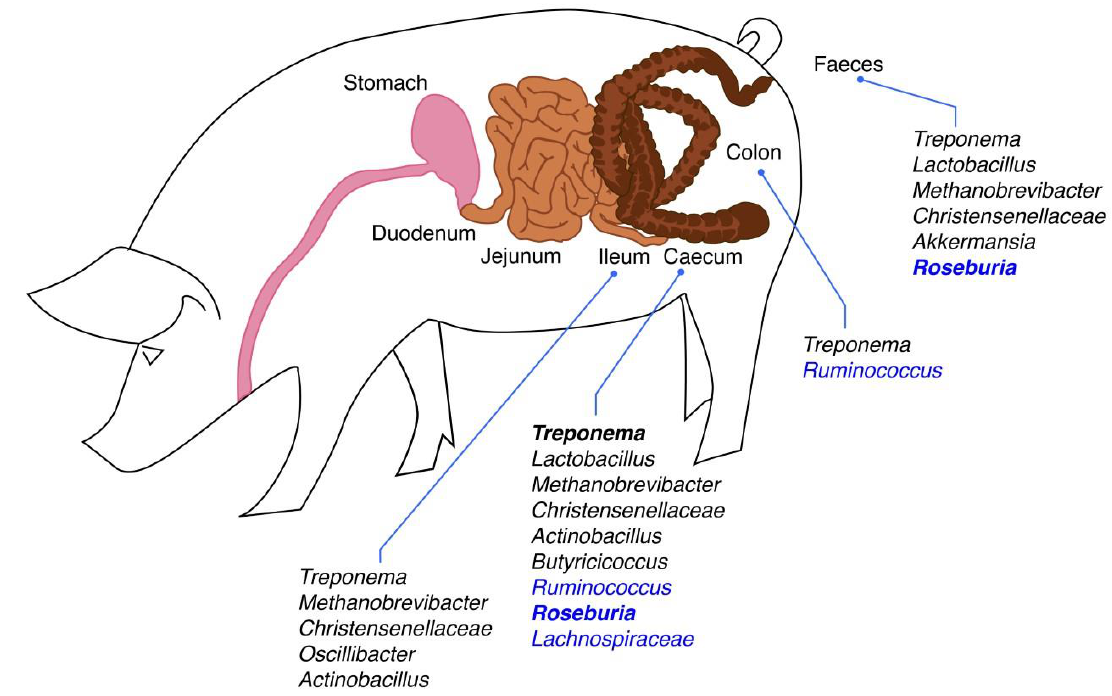
Figure 1. Summary of feed efficiency-associated bacterial taxa in pigs. There are some conflicting data for the taxa in blue, and the taxa in bold are also associated with increased body weight and/or leanness.